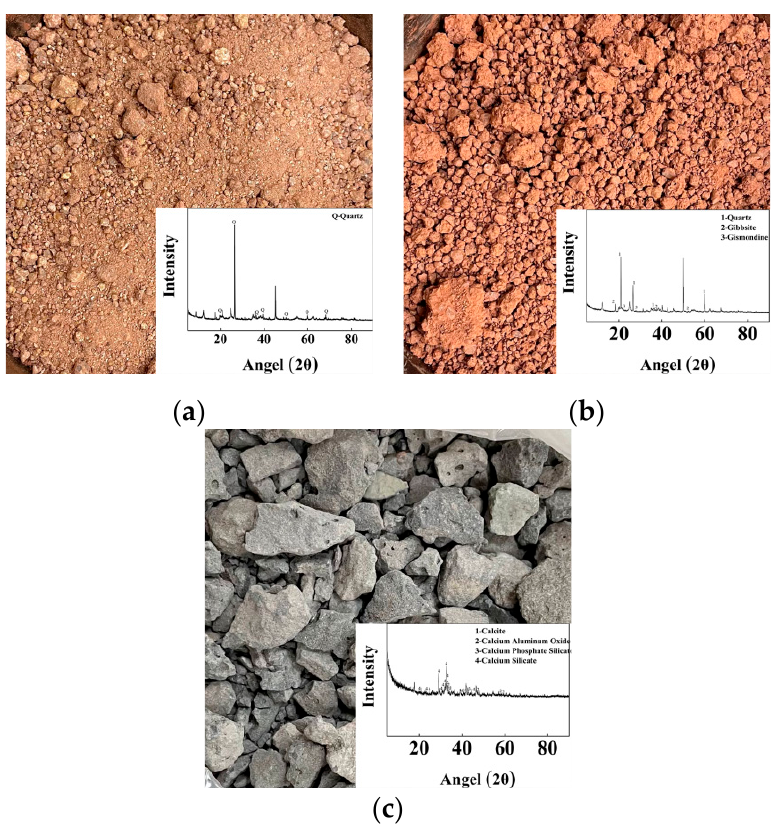
Figure 3. The experimental raw materials and XRD analysis results: ( a ) S1; ( b ) S2; ( c ) SL.